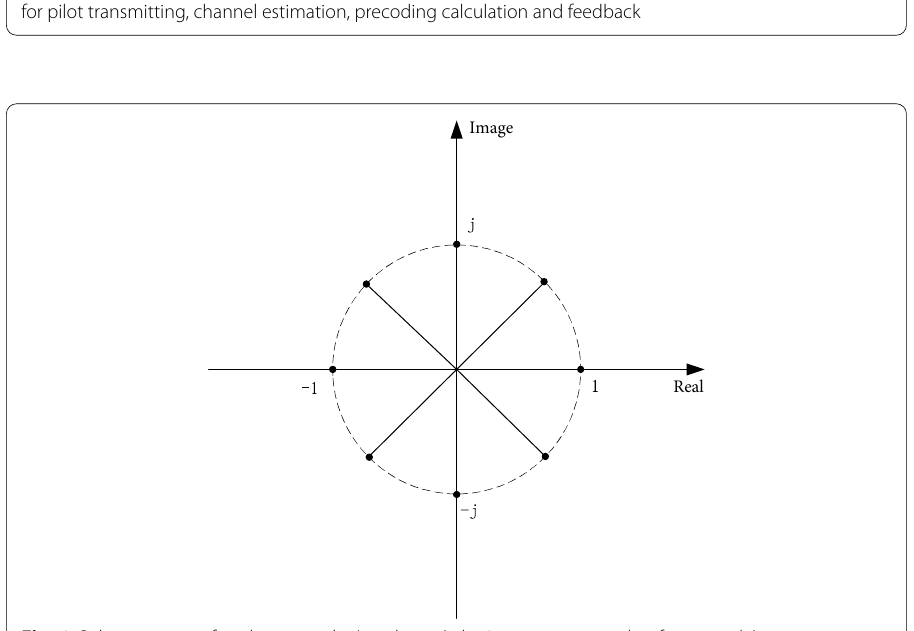
Fig. 6 Solution space of analog precoder/combiner (take 8 as antenna number for